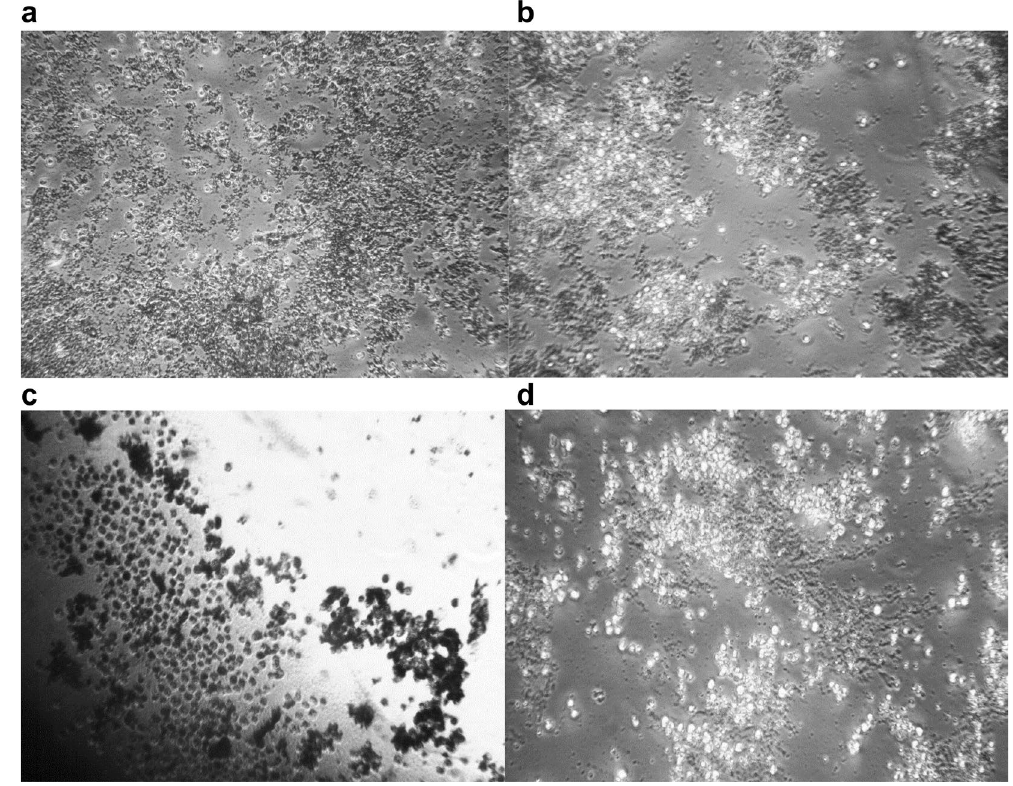
Figure 2. Light microscopic images representing the effect of ACV on co-cultures of monocytes with microbes after incubation for 24 h at 37 °C Cell viability was assessed using trypan blue staining. (A) MRSA, (B) MRSA with ACV, (C) resistant E. coli ; (D) resistant E. coli with ACV.